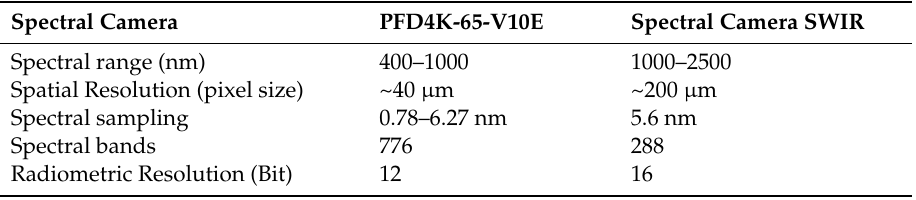
Table 2. Optical characteristics of the hyperspectral